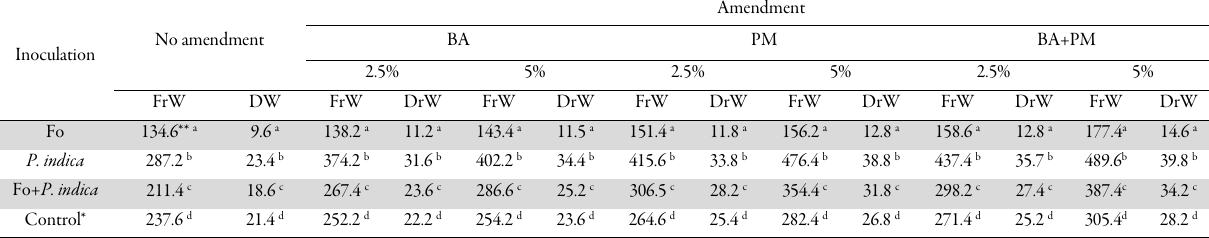
Table 9a. Effect of seed inoculation of cucumber with P. indica and soil amendment with organic wastes on fresh weight (FrW) and dry weight (DrW) per plant six weeks after sowing in autoclaved soil Inoculation